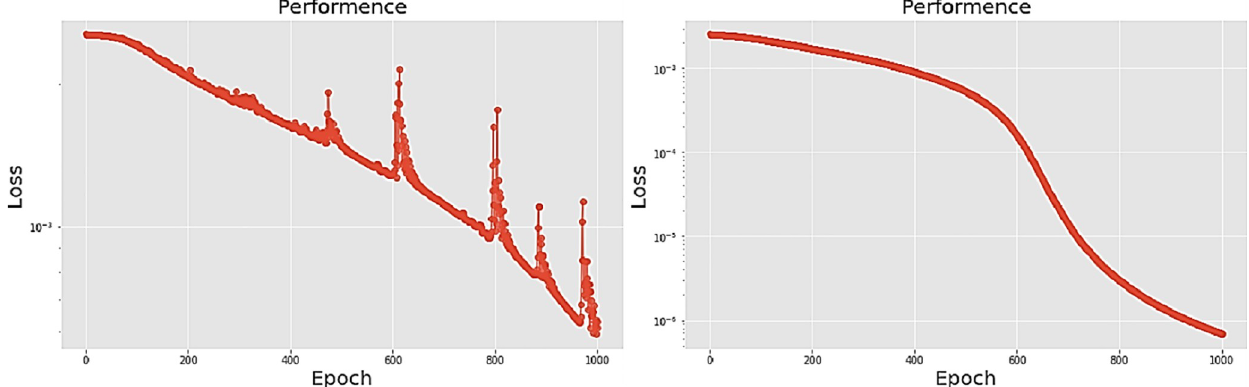
Fig 14. (a) The graph shows the performance of LPC-DNN-16-layer model; (b) The graph shows the performance of LPC-PCA-DNN-16-layer